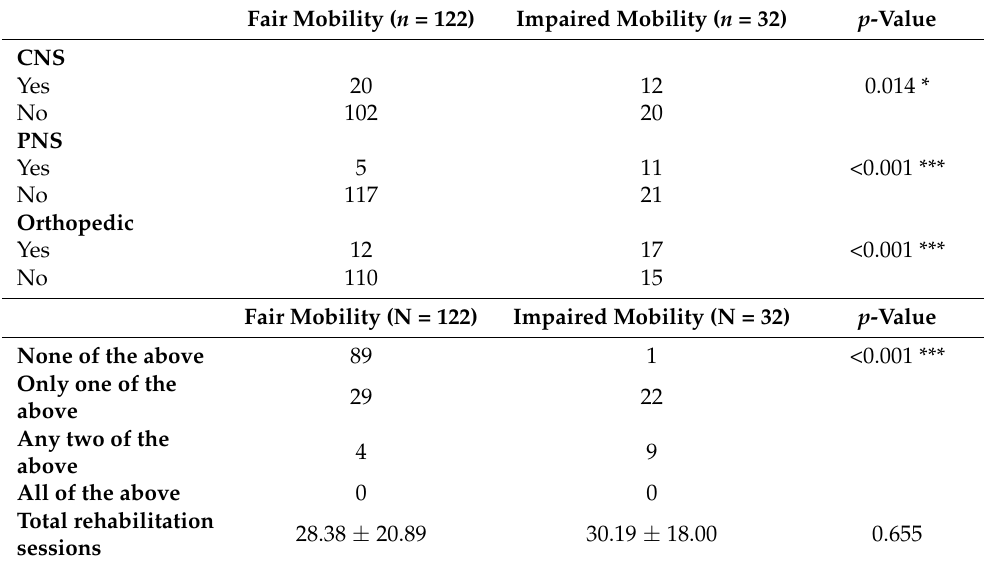
Table 2. Distribution of neurological and orthopedic comorbidities between fair and impaired mobility